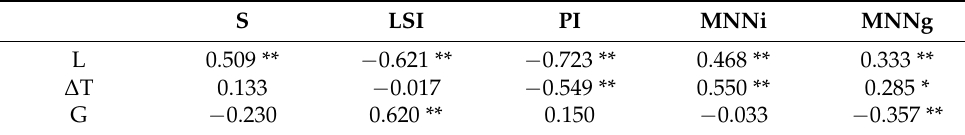
Table 7. Correlation between WCI and impact